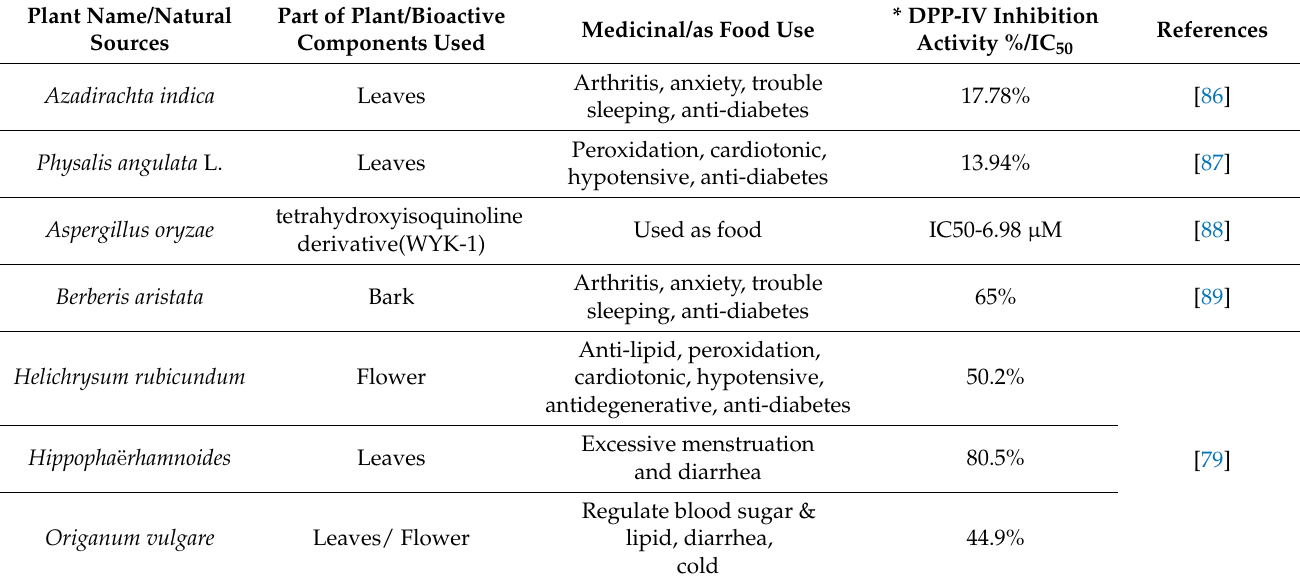
Table 2. DPP-IV inhibitors from various natural sources, bioactive molecules or parts and their inhibition activities. Plant